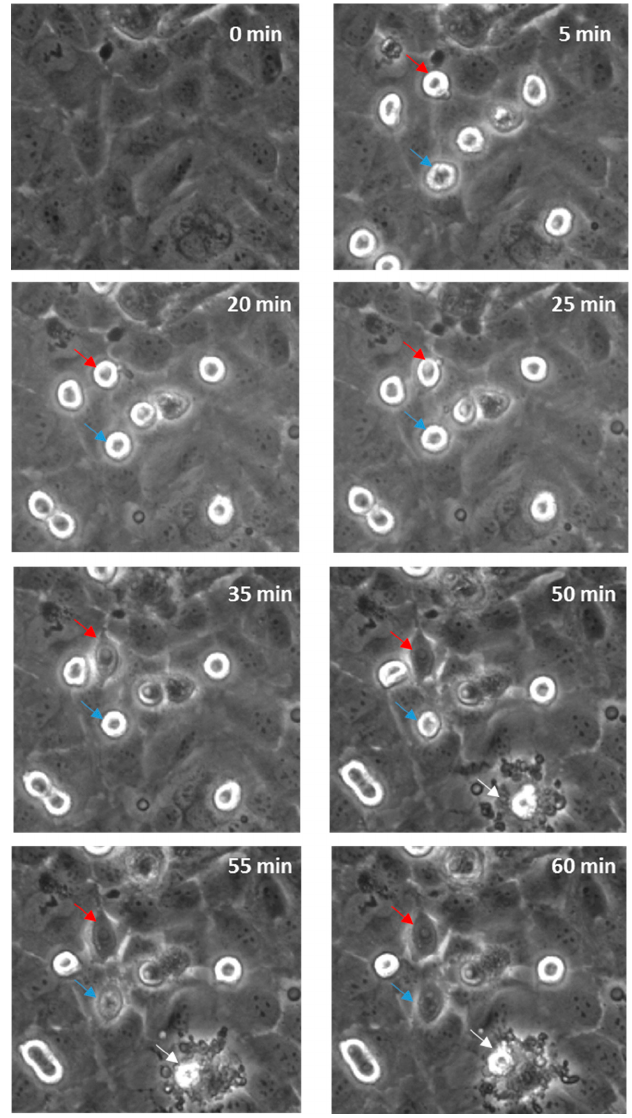
Figure 7. Time-lapse series illustrating melanoma cells (NZM7) adhering to and integrating into hCMVEC endothelial layer. Time 0 represents the time point immediately before the addition of the melanoma cells, which appear spherical and refractile. The red and blue arrows follow spherical melanoma cells above endothelium that distinctly integrate into the endothelial monolayer over time. White arrow indicates evidence of endothelial cell death. Images shown are representative of two independent